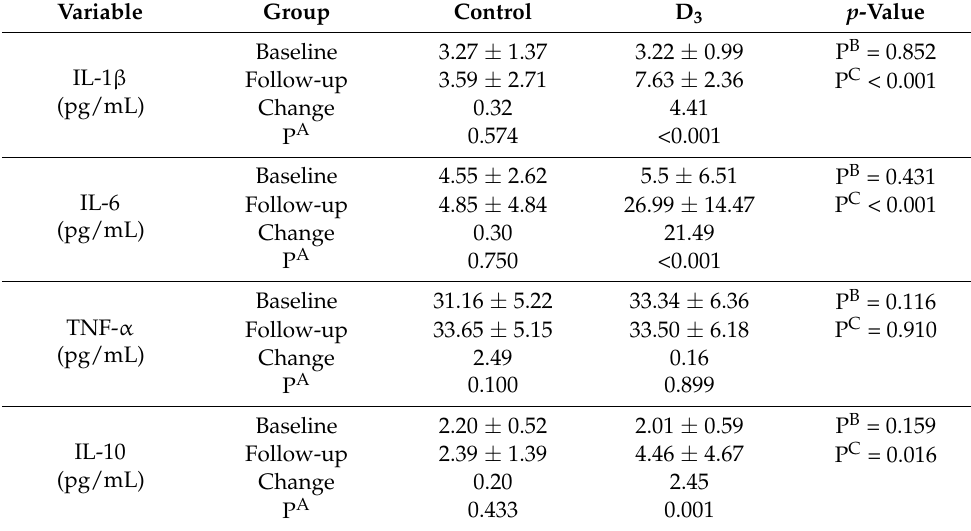
Table 7. Changes in the serum levels of selected cytokines associated with cytokine storm at baseline and 10-week follow-up.